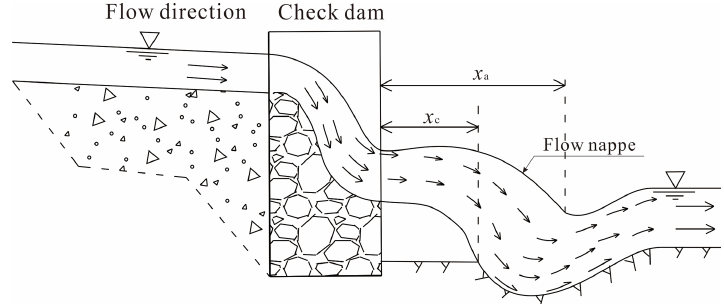
Figure 9. The trajectory of a debris flow nappe.